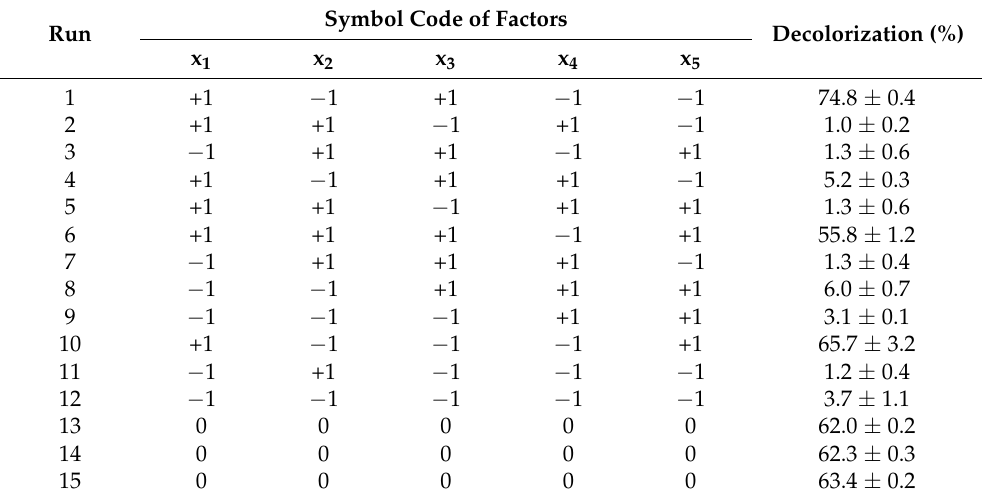
Table 3. Plackett–Burman screening-plan runs and response as percent decolorization at 120 min. Symbol Code of Run